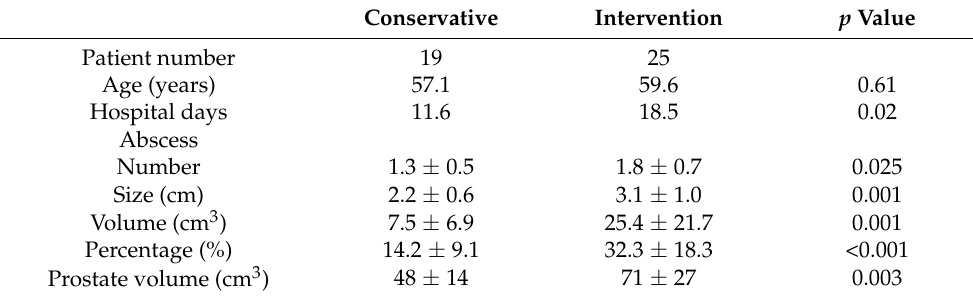
Figure 2. Initial symptoms and comorbidities of patients with a prostate abscess. Table 1. Patients’ profile and abscess